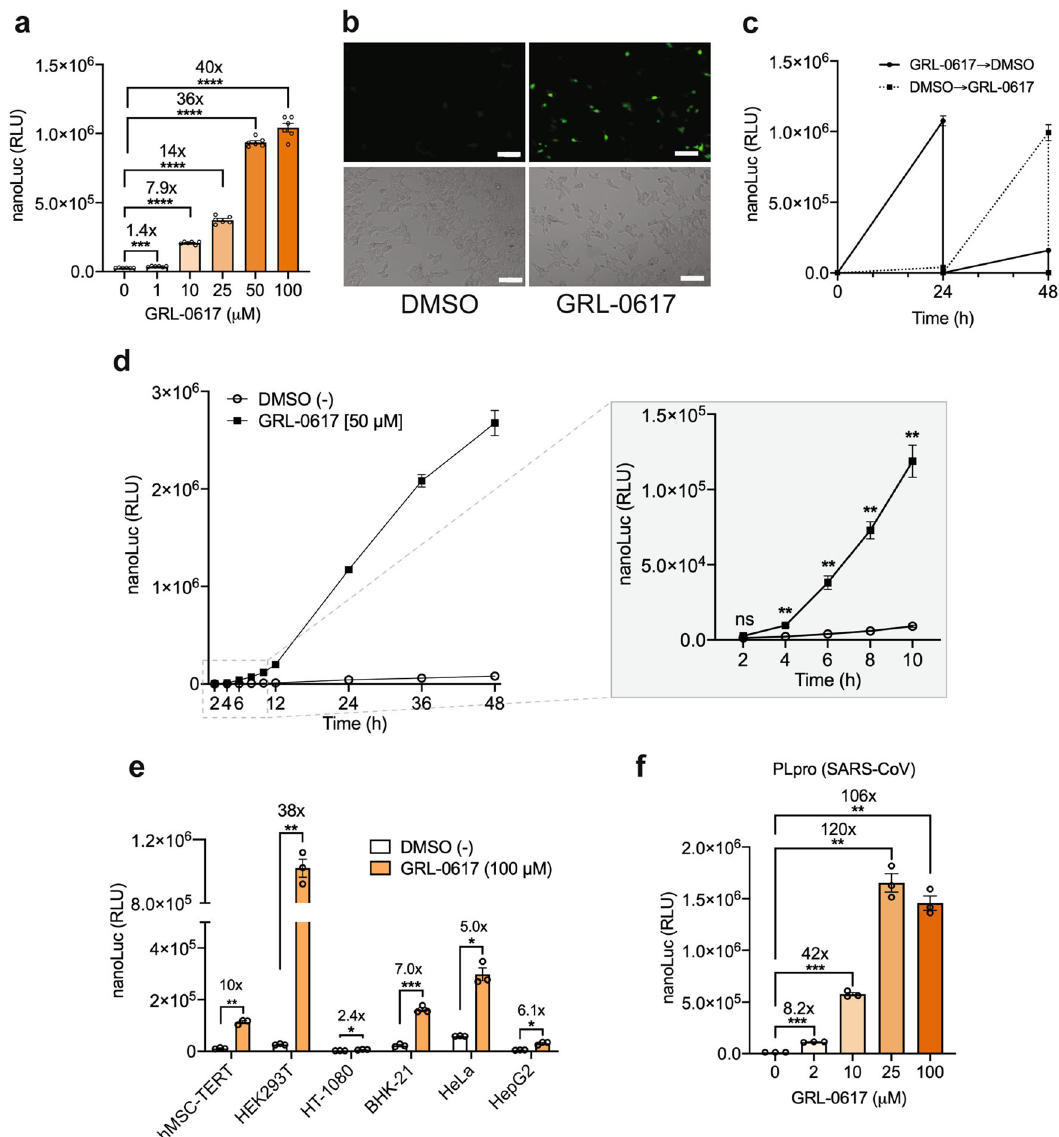
Fig. 2 PLpro-TAGS characterization. a Inducibility and sensitivity of PLpro-based TAGS in the presence of GRL-0617. PLpro-TAGS-transfected HEK293T cells (pNF151 and pNF162) were treated with various concentrations of GRL-0617 for 24 h before measuring the nanoLuc expression. b Phase- contrast and fl uorescence microscopy images of PLpro-TAGS-transfected cells, in which the reporter plasmid encodes the fl uorescent YPet protein. Cells were exposed to DMSO or GRL-0617 (50 μ M) before microscopy analysis. The scale bar corresponds to 100 μ m c Reversibility of PLpro-TAGS. Transfected cells were cultured for 48 h, with medium exchange every 24 h, alternating between DMSO and GRL-0617 (50 μ M)-containing medium. d PLpro-TAGS induction kinetics. PLpro-TAGS-transfected HEK293T cells were grown in a culture medium with or without GRL-0617 for 48 h and luminescence from nanoLuc was measured at various time points. e PLpro-TAGS performance in different mammalian cell lines. Mammalian cell lines expressing PLpro-TAGS were treated with DMSO or GRL-0617 before quantifying the nanoLuc expression level. f Inducibility and sensitivity of PLpro-TAGS based on SARS-CoV PLpro. Transfected cells were treated with different concentrations of GRL-0617 for 24 h before quantifying nanoLuc expression. Plots a , e , and f show the mean ± SEM, with individual data points, n = 3 – 6 biological replicates. Panel b shows representative images from three independent experiments. Plots c , d show the mean ± SEM, n = 3 biological replicates. Statistical signi fi cance was calculated by Welch ’ s two-tailed t -test, * P < 0.05, ** P < 0.01, *** P < 0.001, **** P < 0.0001, ns, not signi fi cant; exact P values are provided in Supplementary Table 7. Numbers above the bars indicate a fold difference in reporter expression level, calculated by dividing the mean expression level in the presence of inducer by the mean reporter expression level in the absence of inducer. Source data for this fi gure is provided in a Source Data fi